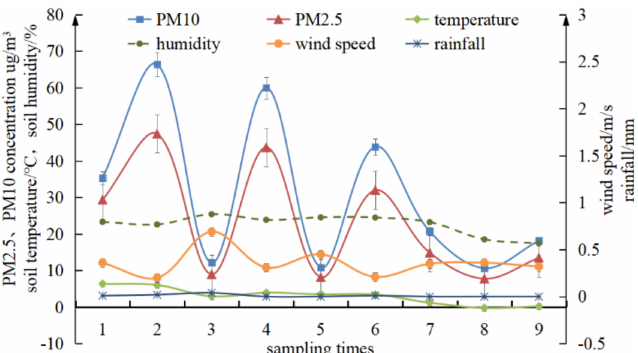
Figure 16. Miyun traditional tillage.